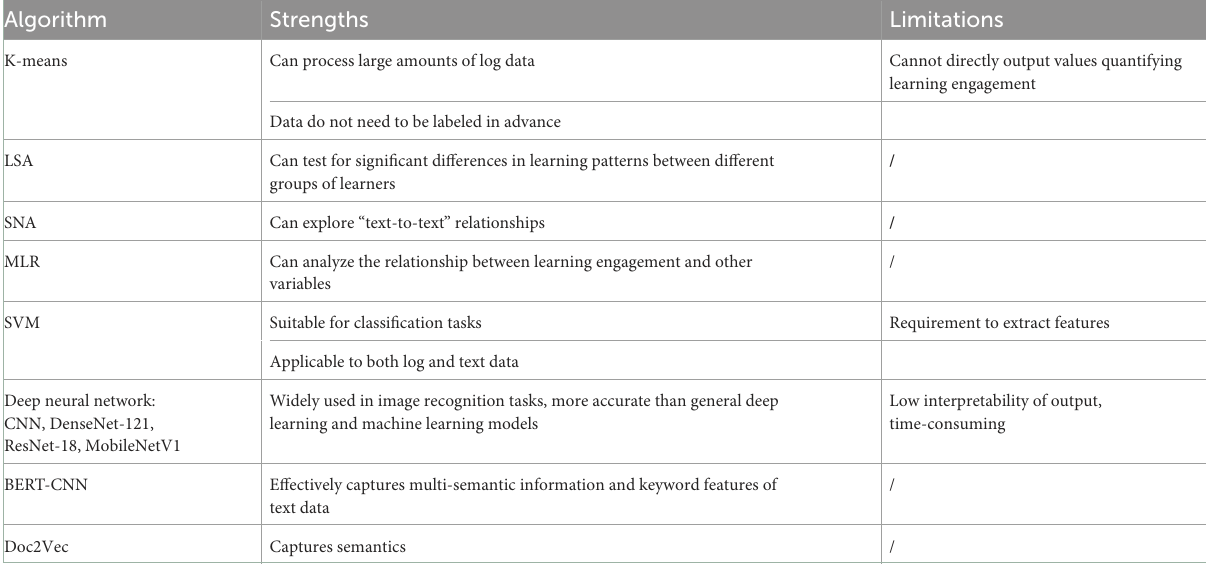
TABLE 12 Strengths and limitations of algorithms used to analyze learning engagement. Algorithm